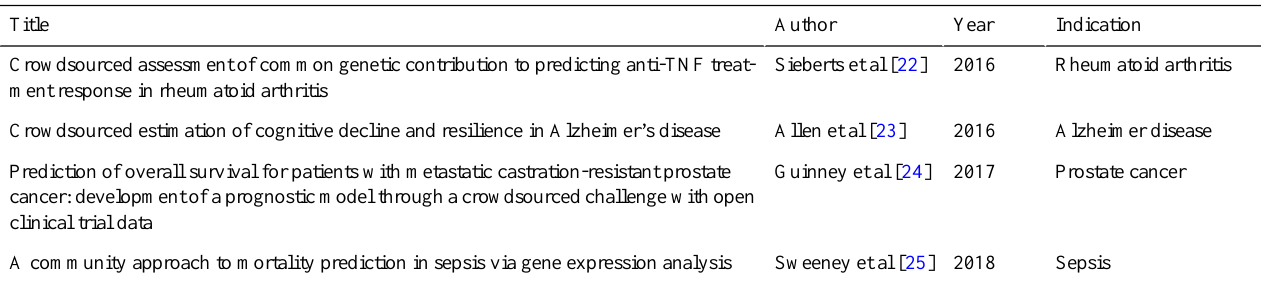
Table 1. Illustrative applications of crowd-sourced heterogeneity.